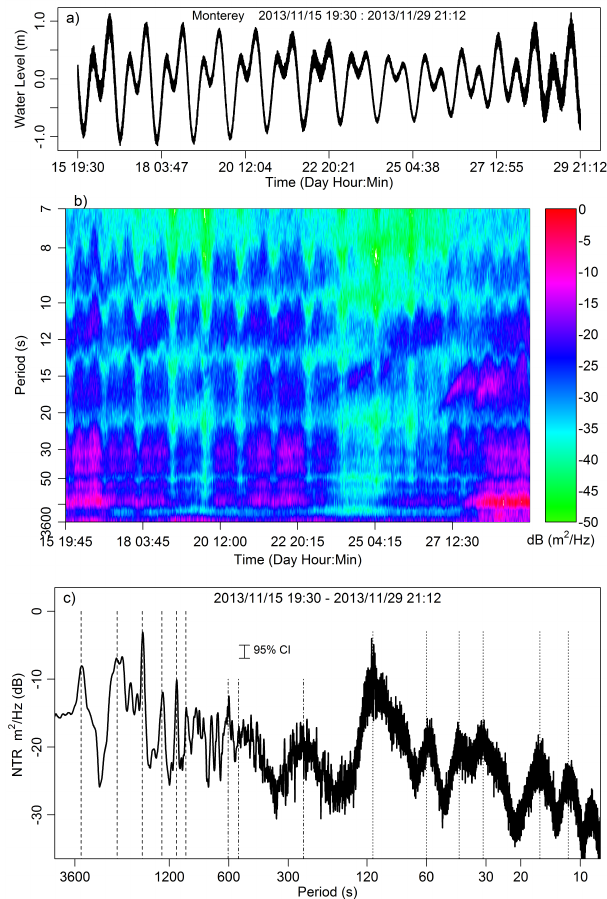
Figure 4. (a) Raw 1Hz water levels from 15 November 2013 through 29 November 2013. (b) Spectrogram of the water levels. (c) Power spectral density estimates of nontide residual water levels. Dashed vertical lines mark the bay-wide resonance modes (55.9, 36.7, 27.4, 21.8, 18.5 and 16.5min), dash-dot lines mark bight peri- ods (10.1, 9.0 and 4.2min) and dotted lines the harbor modes (112, 60, 41, 31, 16 and